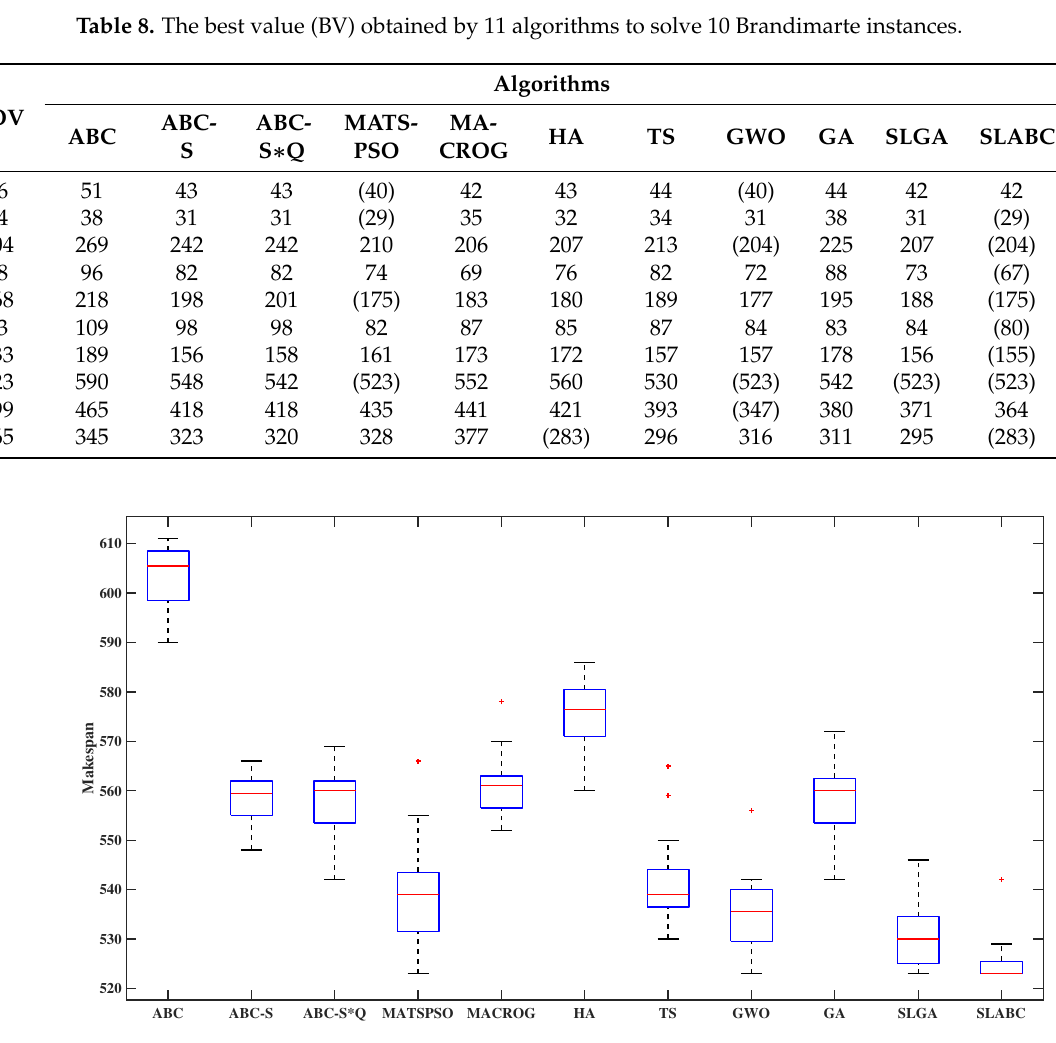
Figure 14. Boxplot of 11 algorithms to solve